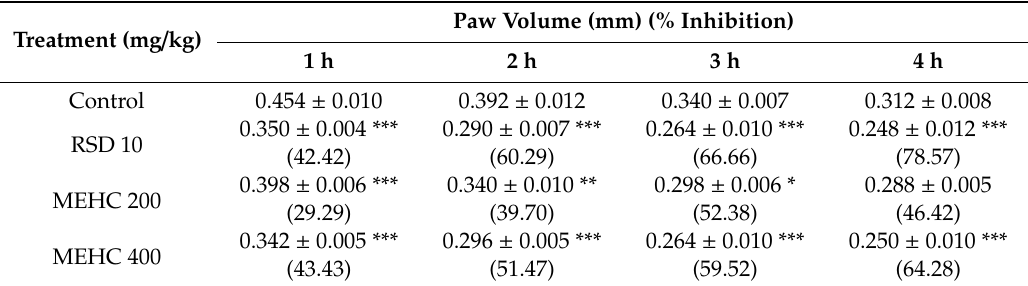
Table 1. Anti-inflammatory e ff ect of methanol extract of Holigarna caustica leaves on histamine-induced paw